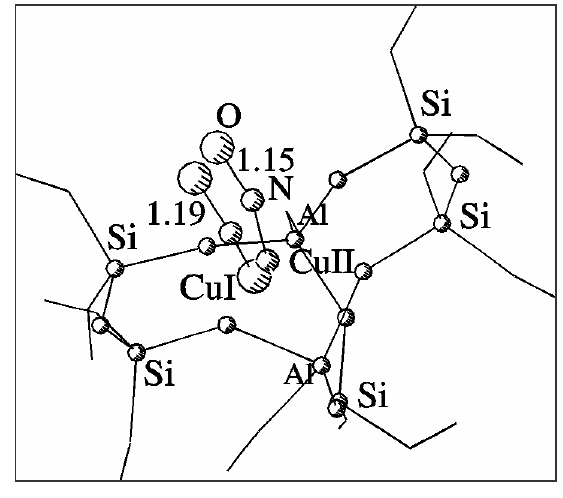
Figure 1. Structure and coordination of Cu 2+ and Cu + sites in a common 7T basket